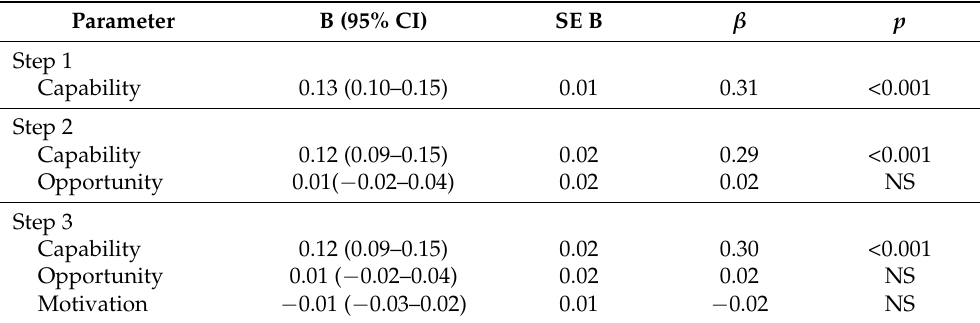
Table 4. Hierarchical regression analysis for change in total PA